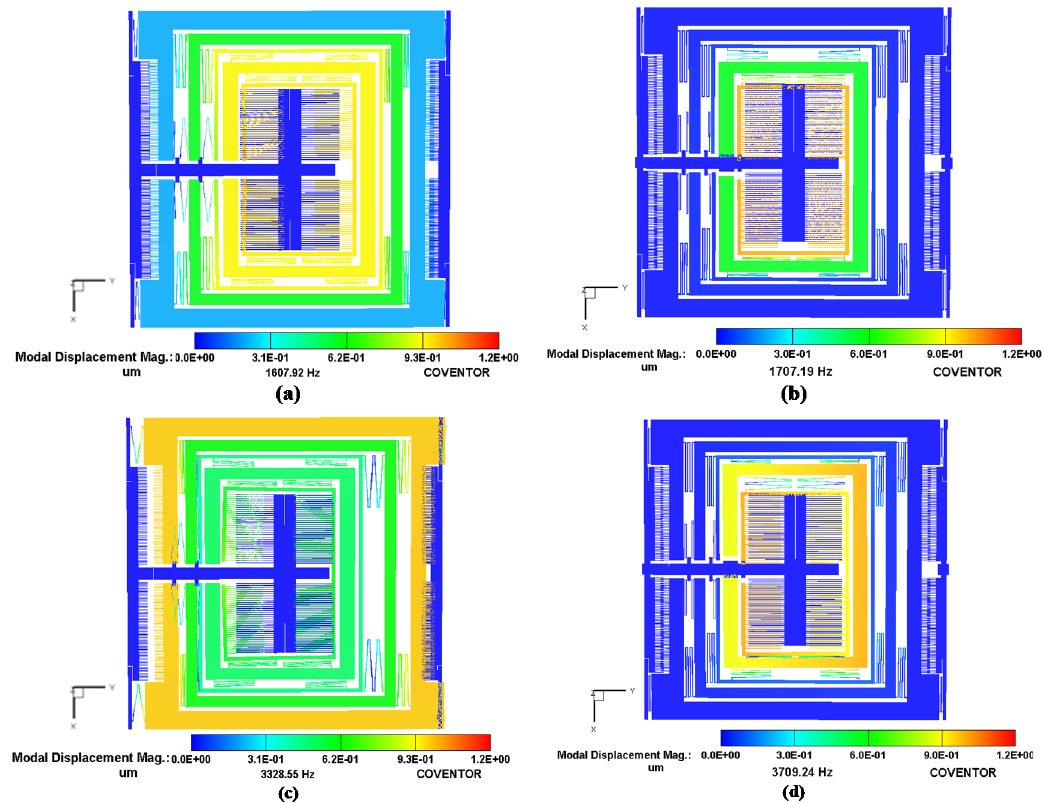
Table 3. Comparison of the analytical and FEM analysis-based modal frequency values.